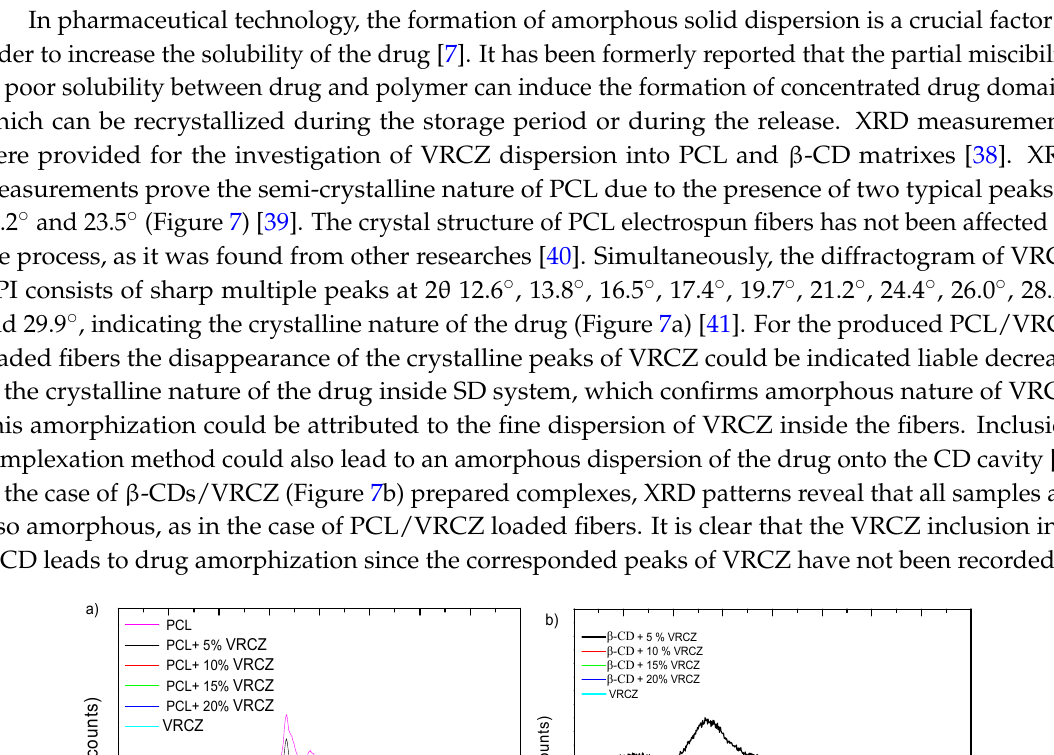
Figure 6. Complexation between VRCZ drug and β -CD.